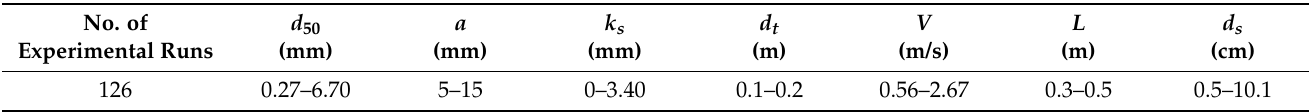
Table 2. Range of collected experimental